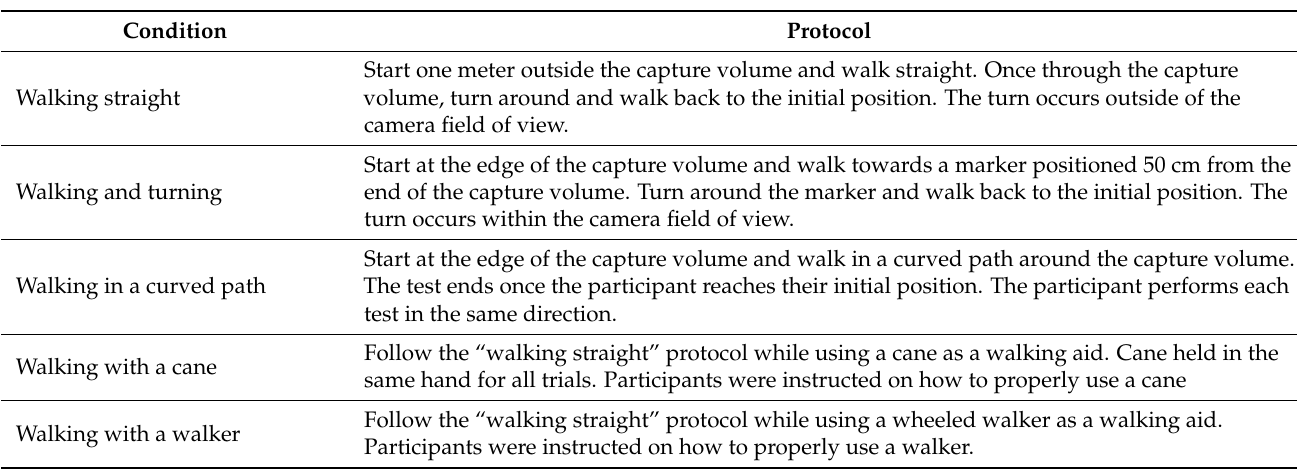
Table 3. Testing protocol for the Smart Hallway